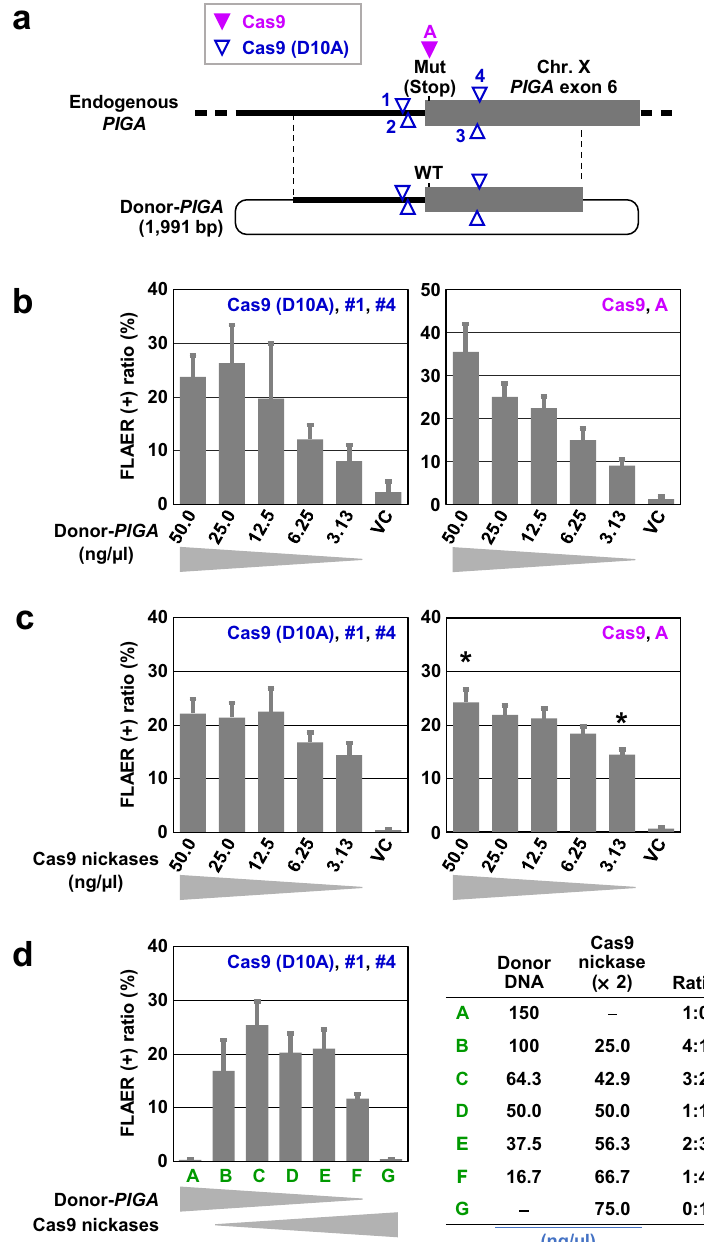
Figure 5. Transfection with a large amount of a donor plasmid leads to efficient targeted knock-in via TPN. (a) Scheme showing the experimental setup of the assay. (b) The efficiency of targeted knock-in achieved using different concentrations of Donor- PIGA . (c) The efficiency of targeted knock-in achieved using different concentrations of Cas9 plasmids. In ( c ), a statistically significant difference in the efficiency of targeted knock-in was observed only between the transfection of 50 ng/µL and 3.13 ng/µL plasmids expressing the Cas9 nuclease (*; p = 0.02) in a concentration range of 3.13–50.0 ng/µL. In ( b , c ), when concentrations of Donor- PIGA and Cas9 plasmids are not denoted on the graphs, these plasmids were used at 50 ng/µL, and the resultant plasmid solutions were supplemented with pBluescript II KS ( +) up to 150 ng/µL. (d) The efficiency of targeted knock-in achieved by transfecting various concentrations of Donor- PIGA and plasmids expressing Cas9 nickases. The sum of three plasmid concentrations was fixed at 150 ng/µL as shown to the right of the graph. Data obtained with experimental conditions B–F were not significantly different. In ( b – d ), 50 ng/µL plasmids (1 μg plasmids dissolved into 20 µL electroporation buffer per sample) correspond to 15.5 nM (Donor- PIGA ; 4895 bp including a 1991 bp homologous region) or 8.3 nM (Cas9 plasmids; 9178 bp) in molar concentration. Data represent the mean and SEM values of three independent